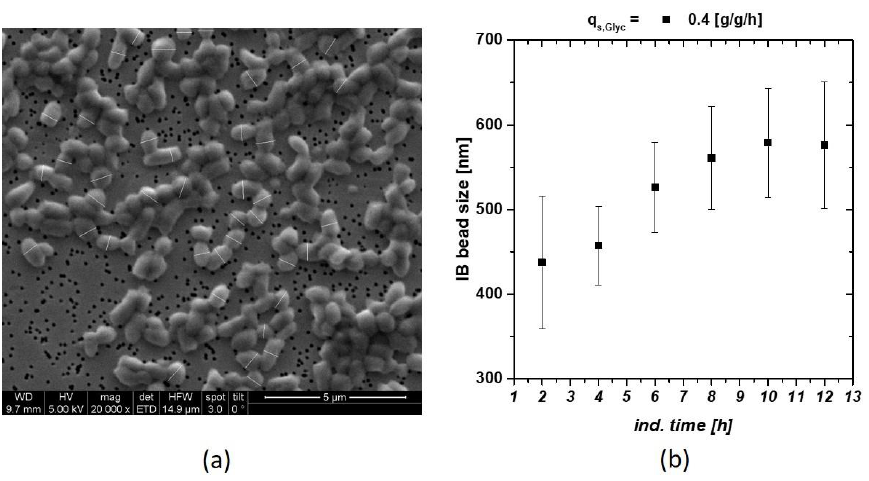
Figure 1. ( a ) Inclusion body (IB) beads at time point of harvest (12 h of induction) including measurement bars (white) after homogenization and subsequent washing with ultrapure water; ( b ) IB bead size at q s,C of 0.4 g/g/h using glycerol as C-source. Late degradation is based on reduction in the viable cell concentration.